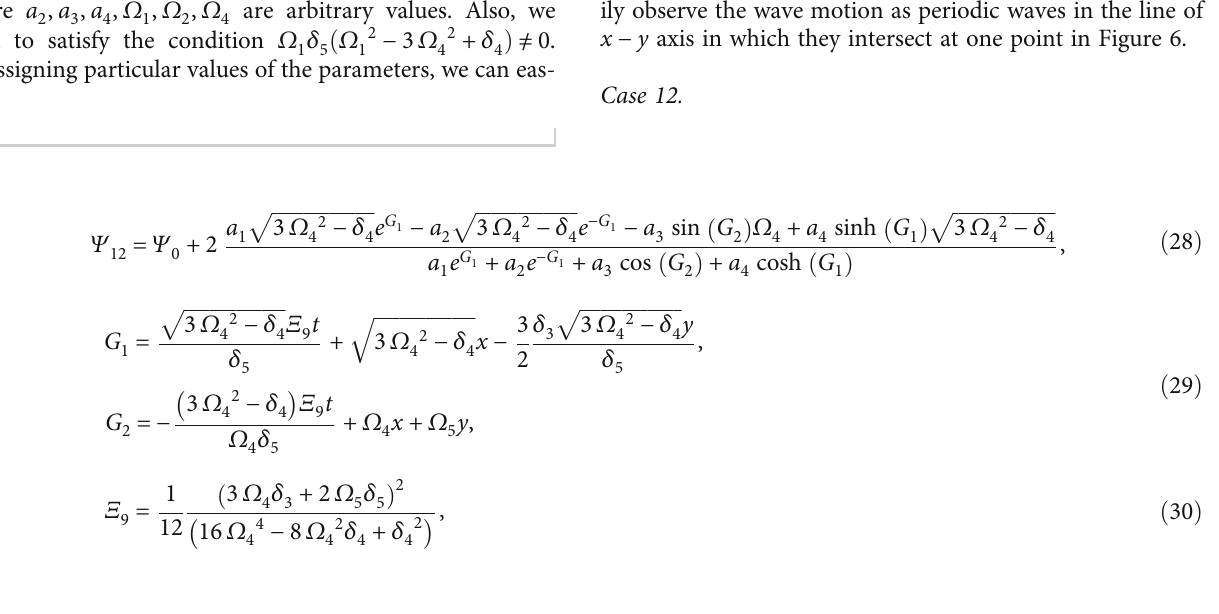
Figure 3: Plot evolution of periodic waves (16) utilizing values a = 2, δ = 1 : 3, δ = 2, Ψ = 1, t = 10 and (a) 3D plot, (b) density plot, and (c) contour plot. 4 5 0